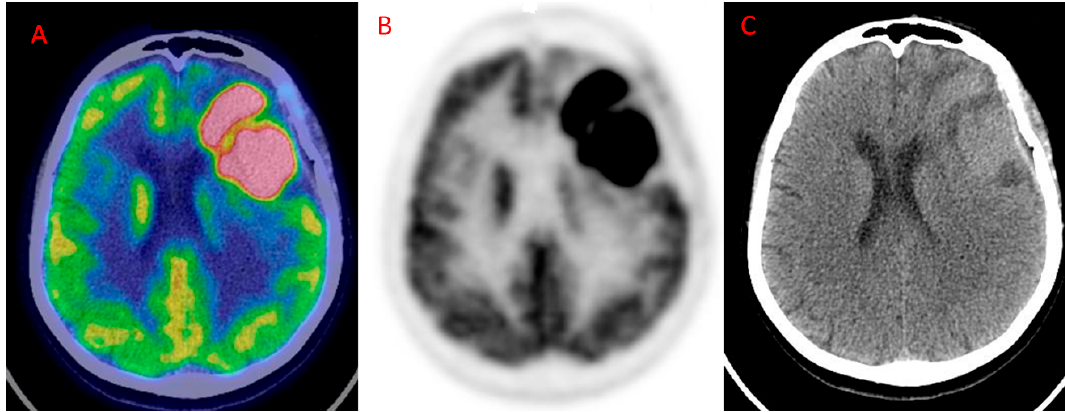
Figure 1. Primary Central Nervous System Lymphoma (PCNSL) in the left frontal cortex showing high 18 F-FDG uptake. ( A ) Axial fused 18 F-FDG PET / CT; ( B ) 18 F-FDG PET; ( C ): CT. (Courtesy of Dr. Cistaro). In summary, 18 F-FDG PET is e ff ective for di ff erentiating PCNSL from GBM, which